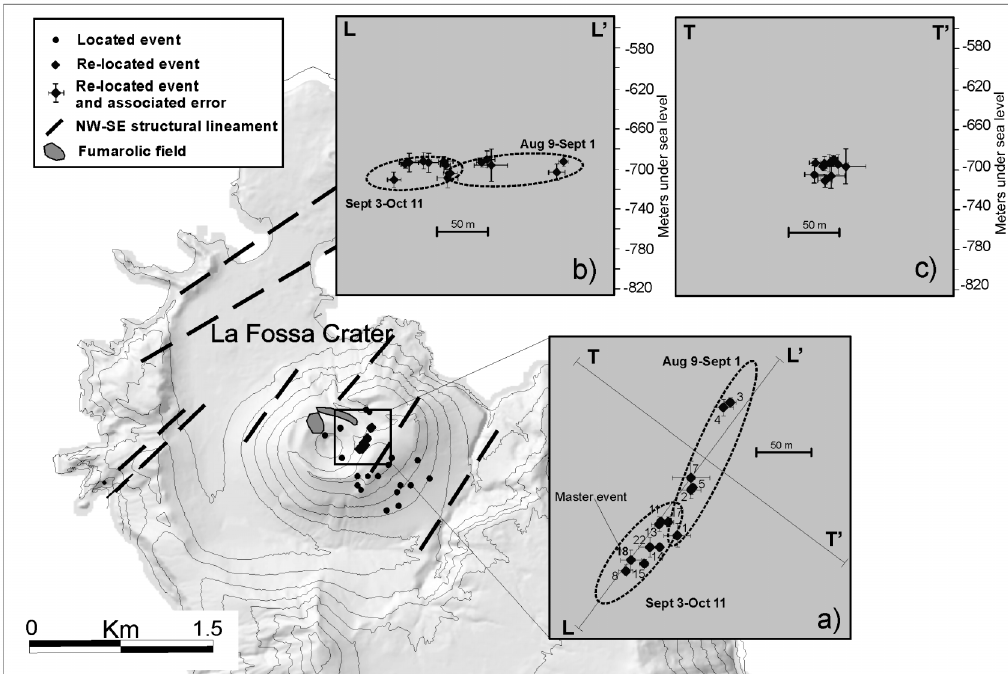
Fig. 6 a-c. Epicentral map of located and relocated events. The insets represent the enlarged map (a), L-L’ (b) and T-T’ (c) cross-sections of relocated events. Origin coordinates and depth refer to n. 18